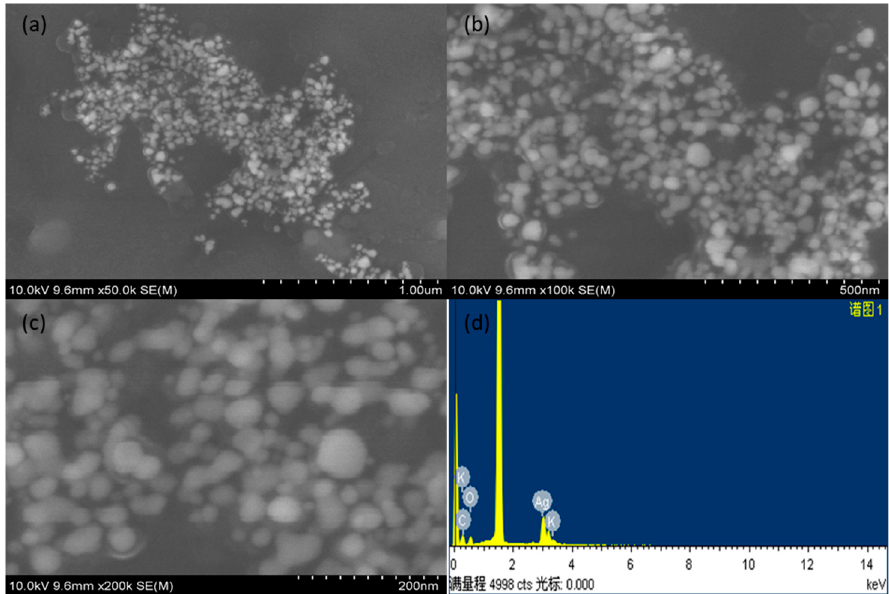
Figure 2 . TEM images ( a – c ) and size distribution ( d ) of silver nanoparticles. Figure 2. TEM images ( a – c ) and size distribution ( d ) of silver nanoparticles.